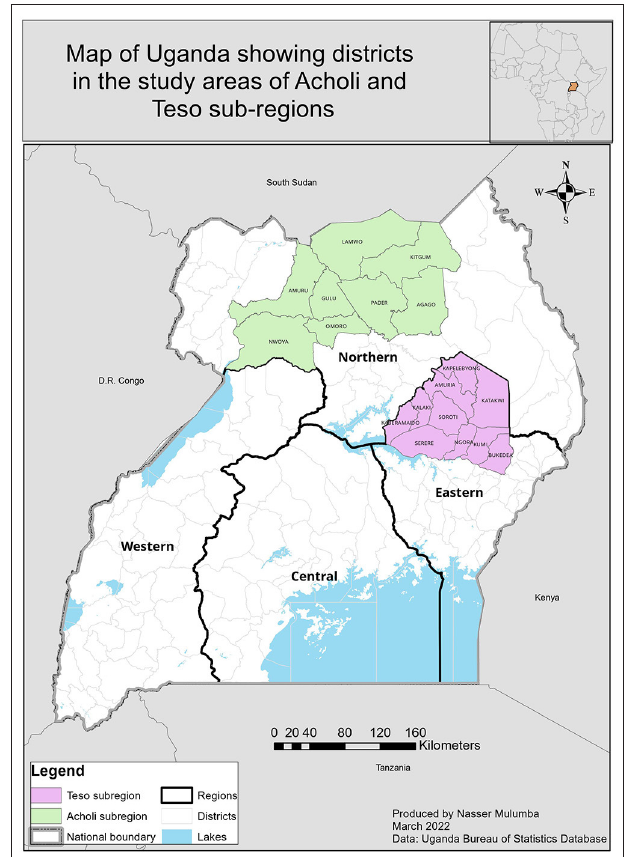
FIGURE 1 | Map of Uganda highlighting Teso (purple) and Acholi (green) sub-region and